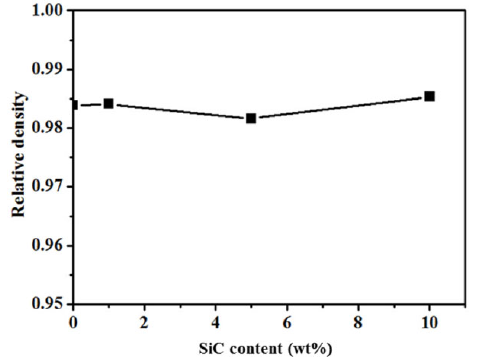
Fig. 3 Relative density of SiC w /Ti 3 SiC 2 as a function of SiC w after SPS at 1350 ℃